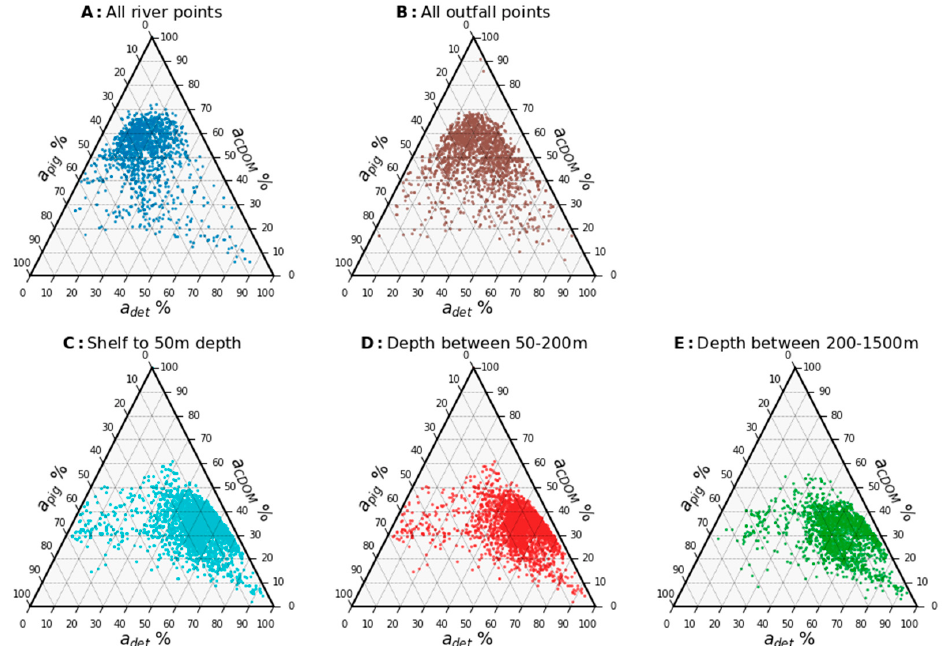
Figure 6. Ternary graphs for all five groups (land-sourced—upper line ( A , B ), inwater points—second line ( C – E )). All points for all acquisitions are plotted for each group.